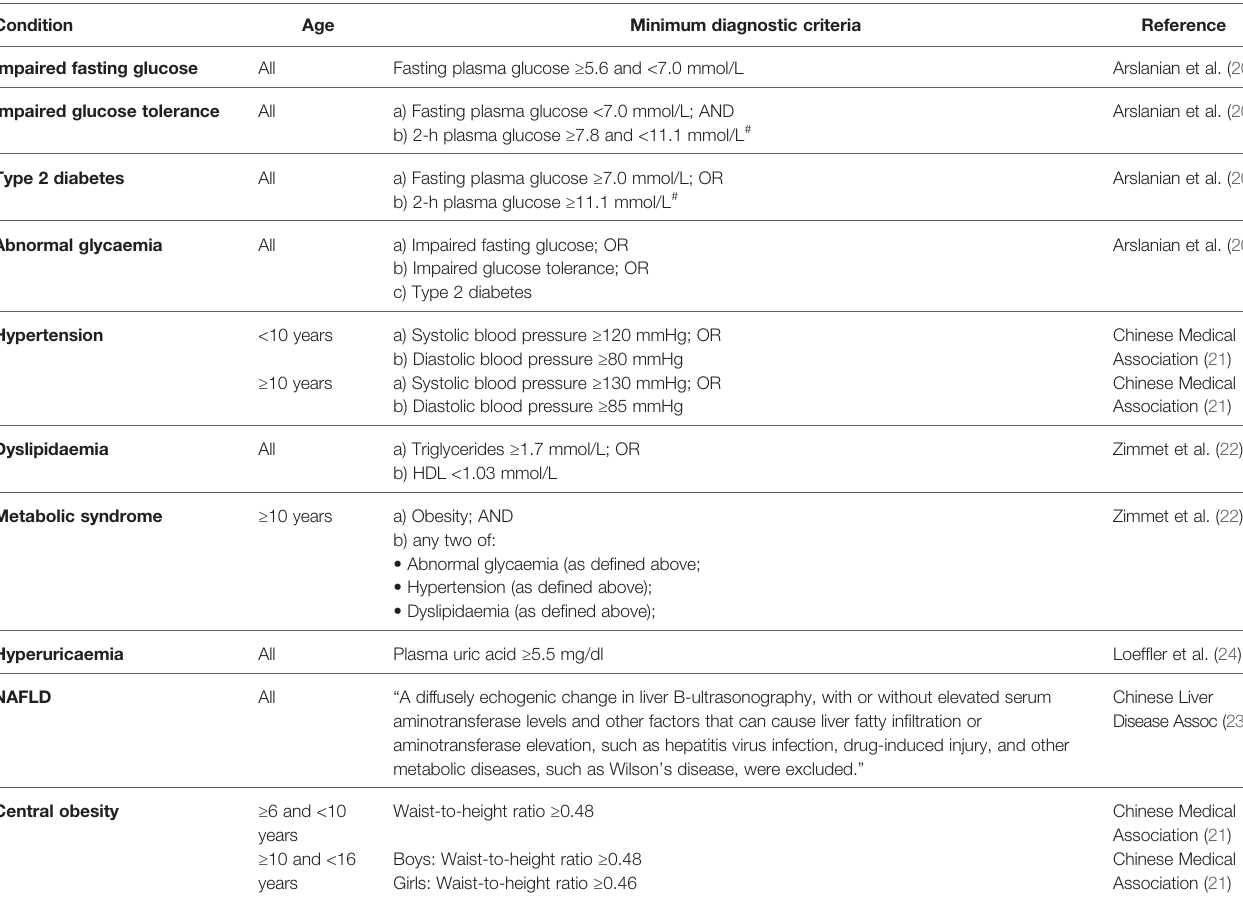
TABLE 1 | Diagnostic criteria for central adiposity and obesity-related cardiometabolic comorbidities assessed.